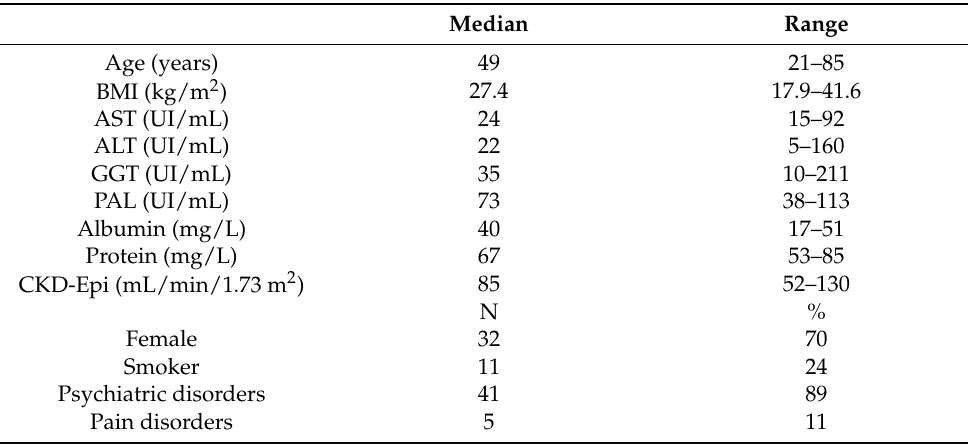
Table 2. Sociodemographic and clinical characteristics ( n = 46